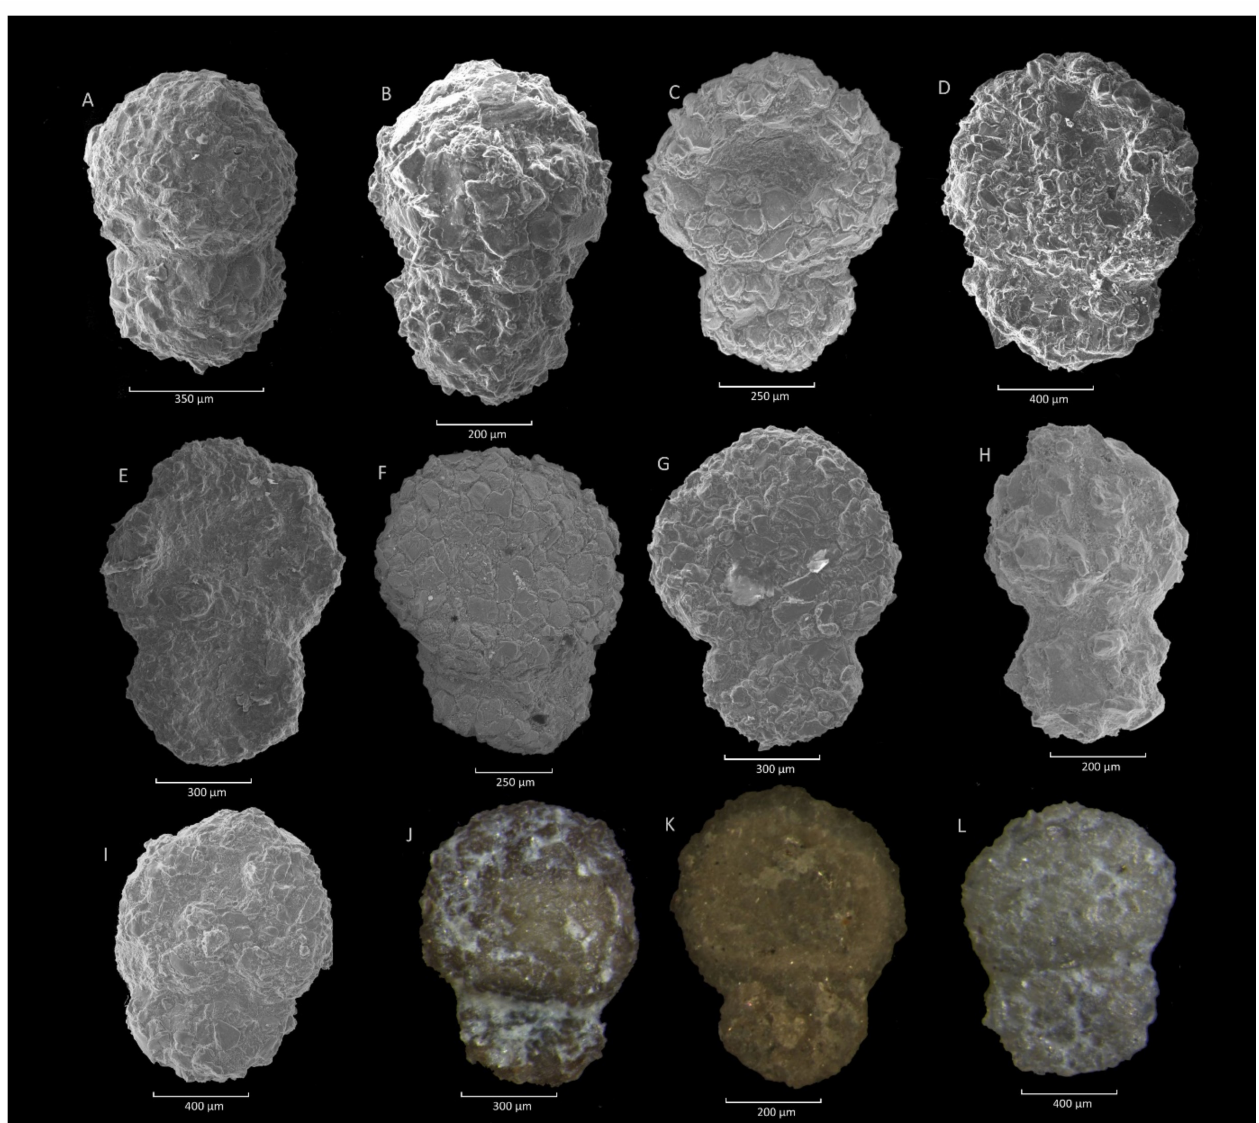
Figure 17. Reophax duplex (Grzybowski). ( A ): Por˛eby-Czarnot ó wki section; ( B , D , G – I ): Krzesławice section; ( C , F ): Lipie section, ( E ): Sucha Beskidzka section; ( K ): Leszczawa section; ( L , J ): Ropica